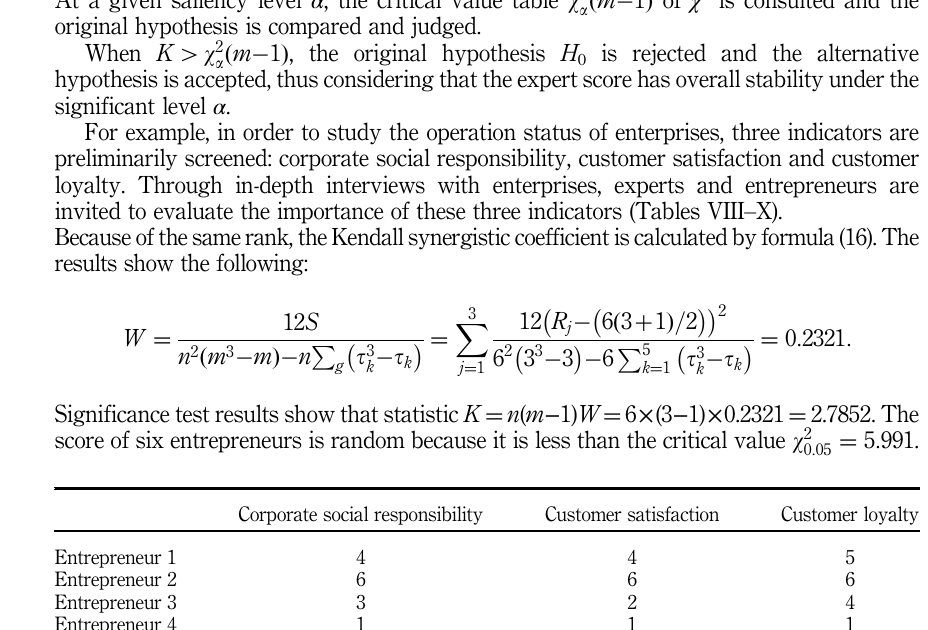
Table VIII. Indicators of expert appointment